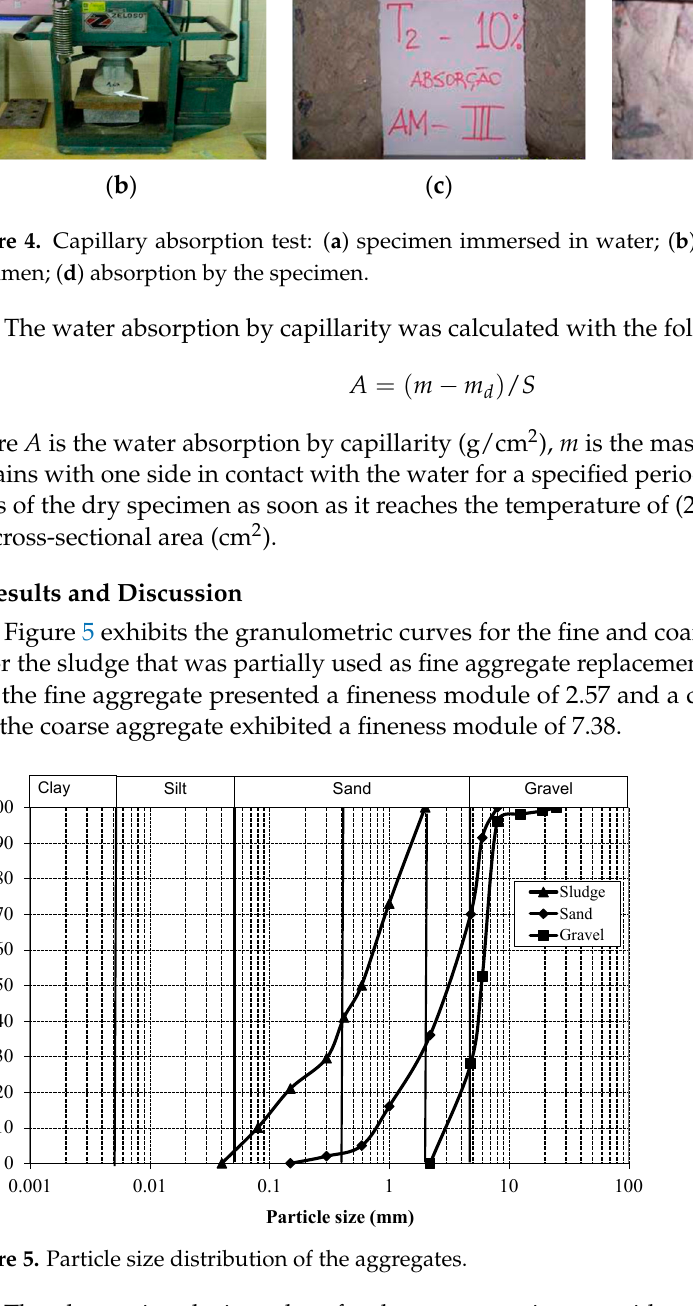
Figure 6. Ultrasonic velocity versus healing time for: ( a ) conventional concrete, concrete with sew- age sludge, and with CDW [27] for w/c = 0.57; and for ( b ) conventional concrete and concrete with sewage sludge for w/c = 0.65. The results showed that the values of ultrasonic velocity decreased with the percent- age increase of the sludge content; however, these values were higher than the values obtained by [27] for concrete made with CDW. However, the UPV values for the two con- crete samples (see Figure 6) analyzed were within the range that characterizes the concrete as good quality; i.e., UPV values between 3500 m/s and 4500 m/s [34]. Figure 7 showed the average values of the sclerometer index values in function of the healing time, obtained in the tests, and the results presented by [27] for comparison pur- poses. The results obtained showed that sclerometer index values decreased with the in- crease in sludge content for both w/c ratios investigated − 0.57 and 0.65. A comparison with concrete made with CDW, presented by [27], showed lower sclerometer index values than the values obtained by [27]. The justification for this behavior may be associated with